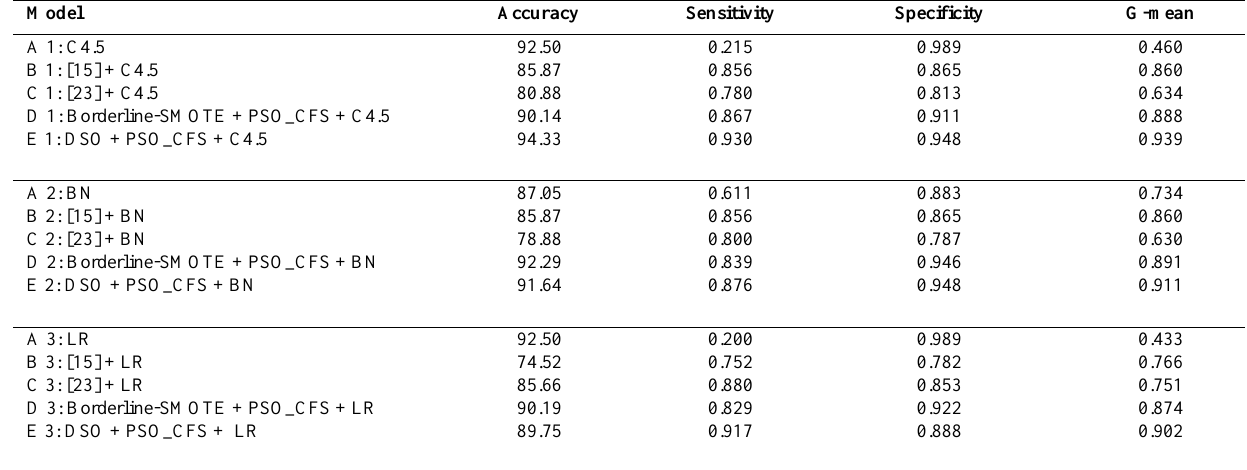
Table 5. Average performance of models.